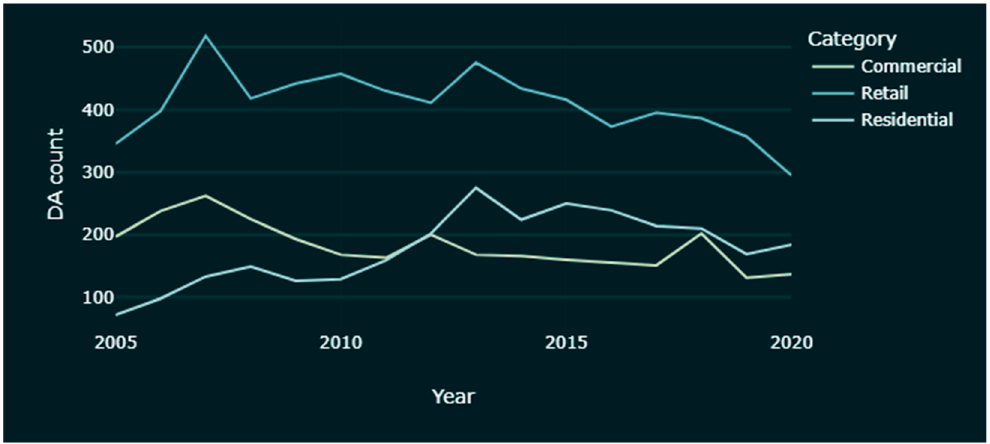
Figure 35. Total estimated cost of approved DAs by proposed uses over time (2005–2021).